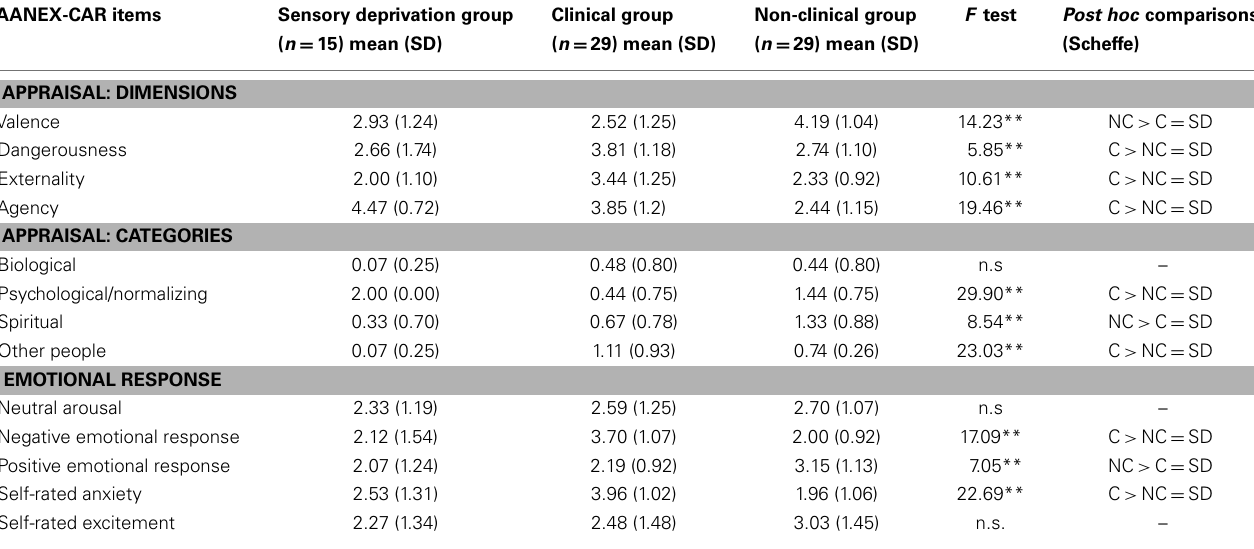
Table 2 |Appraisals under sensory deprivation compared with Lovatt et al. groups (25) . AANEX-CAR